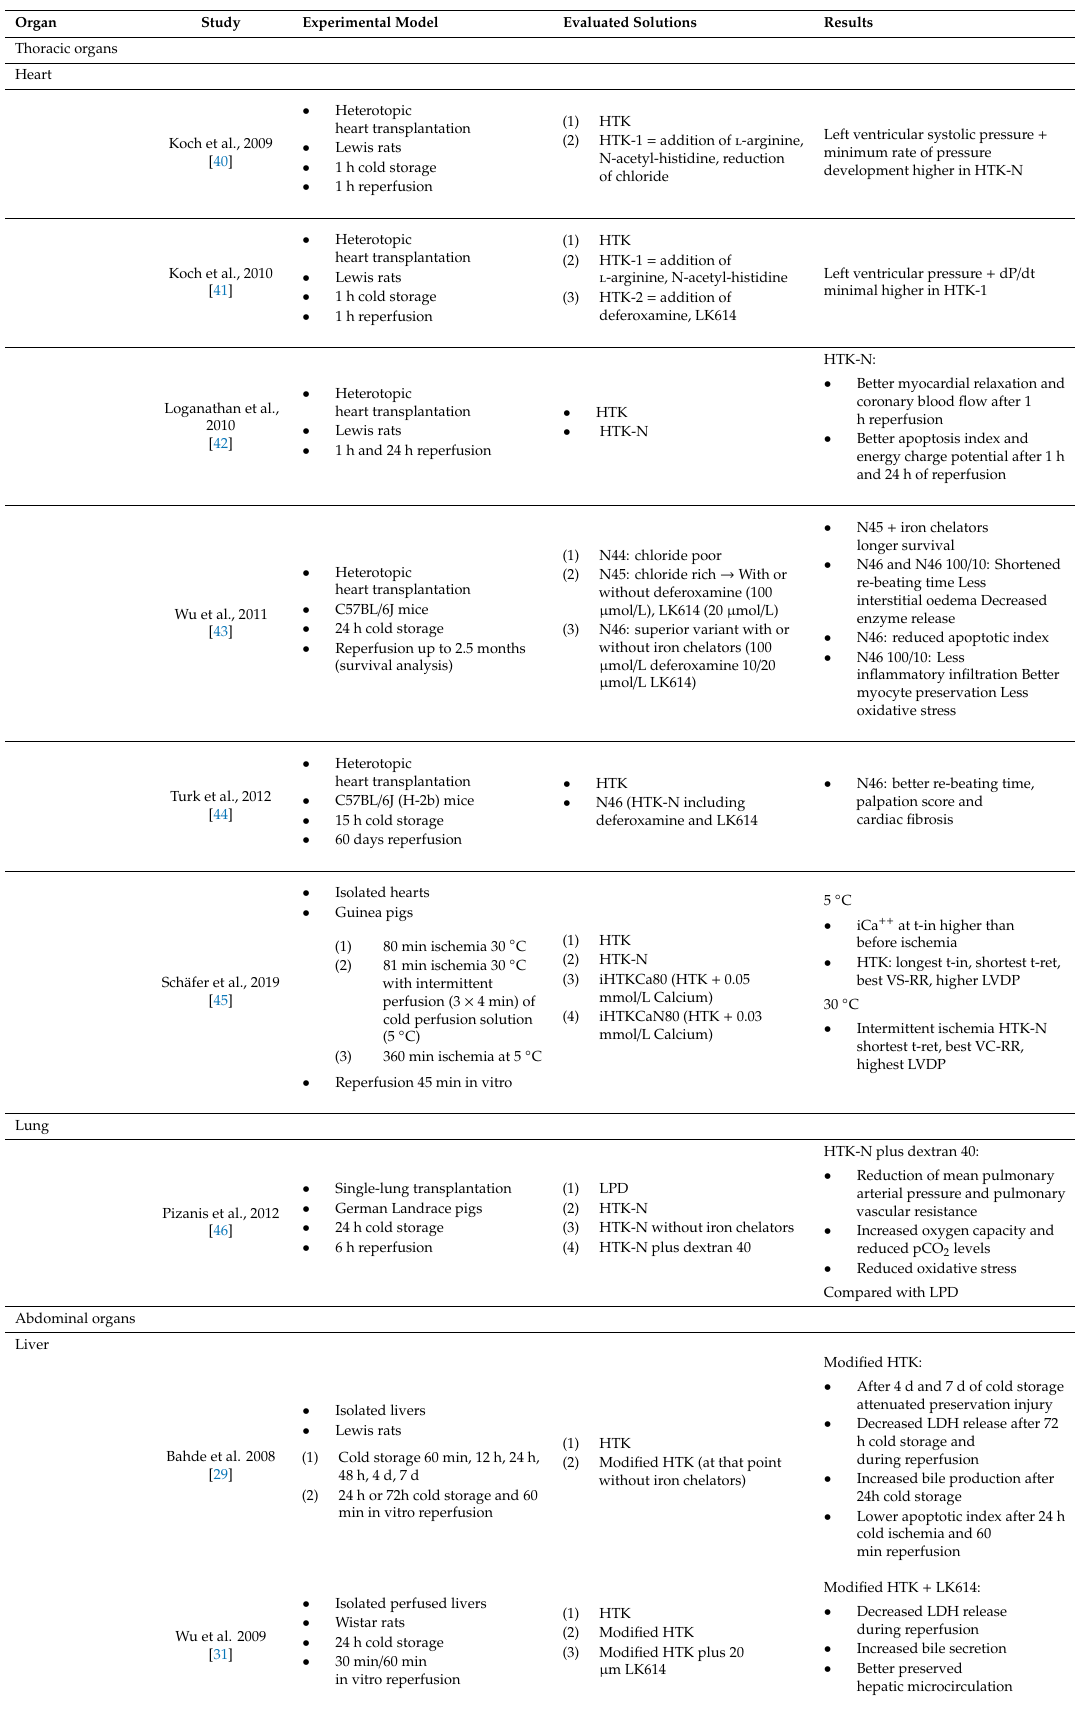
Table 3. Animal Studies Evaluating the Impact of